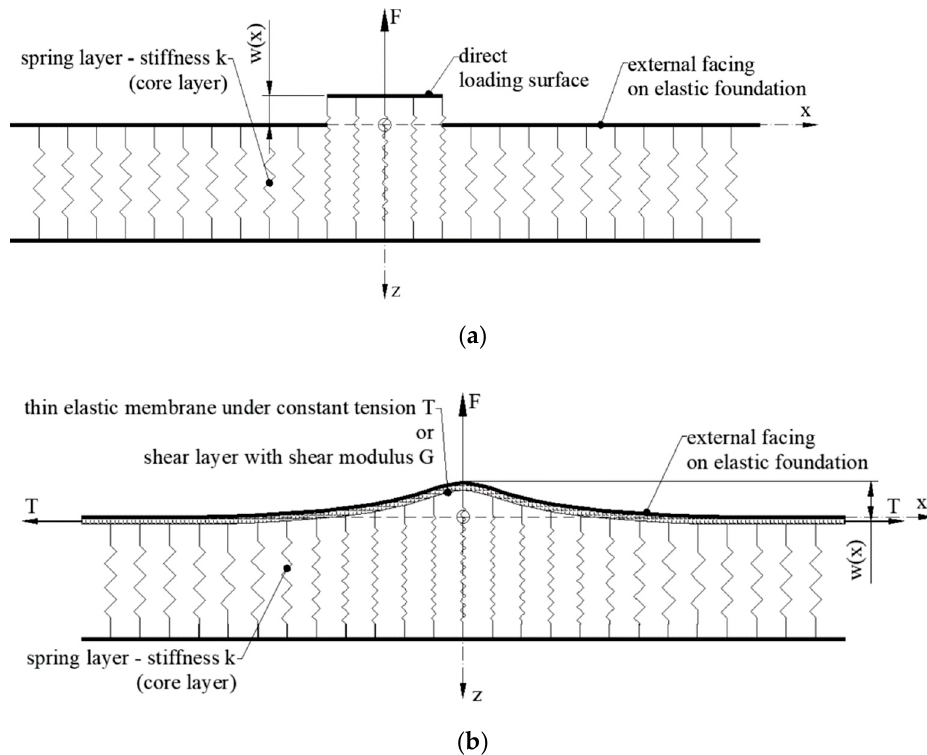
Figure 5. Facing–core interaction according to analytical models: ( a ) Winkler model, ( b ) Filonenko-Borodich/Pasternak model.